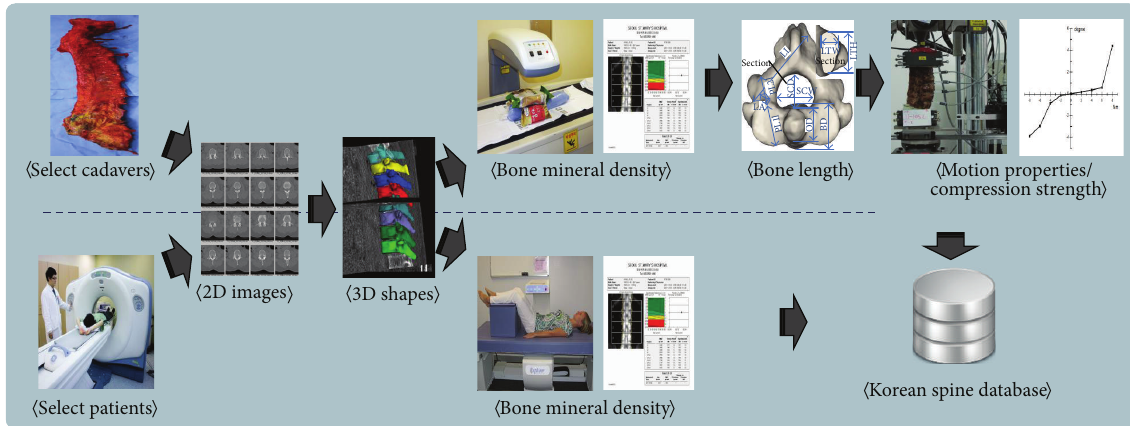
Figure 3: Process of the Korean spine database construction.